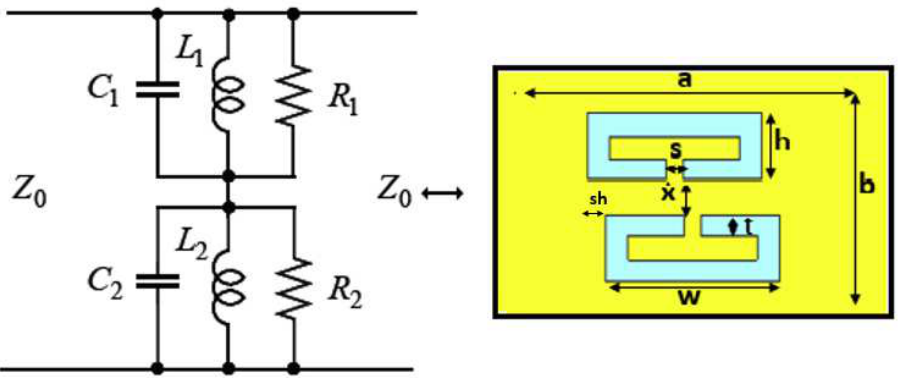
Figure 5. Rectangular meta-resonator and its simple lumped model RLC